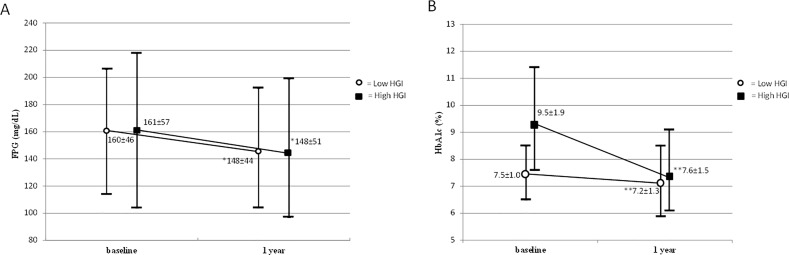
Mean value from baseline to 1 year of dipeptidyl peptidase-4 inhibitor treatment in two groups according to baseline hemoglobin glycation index (HGI) in fasting plasma glucose (FPG) (p = 0.965) (A) and glycated hemoglobin (HbA1c) (p < 0.001) (B). Data are presented as mean ± standard deviation (SD). * p = 0.002, **p<0.001 compared with baseline; where ‘p’ represents p-value of between-group difference. (To convert glucose to millimoles per liter, multiply by 0.0555.)